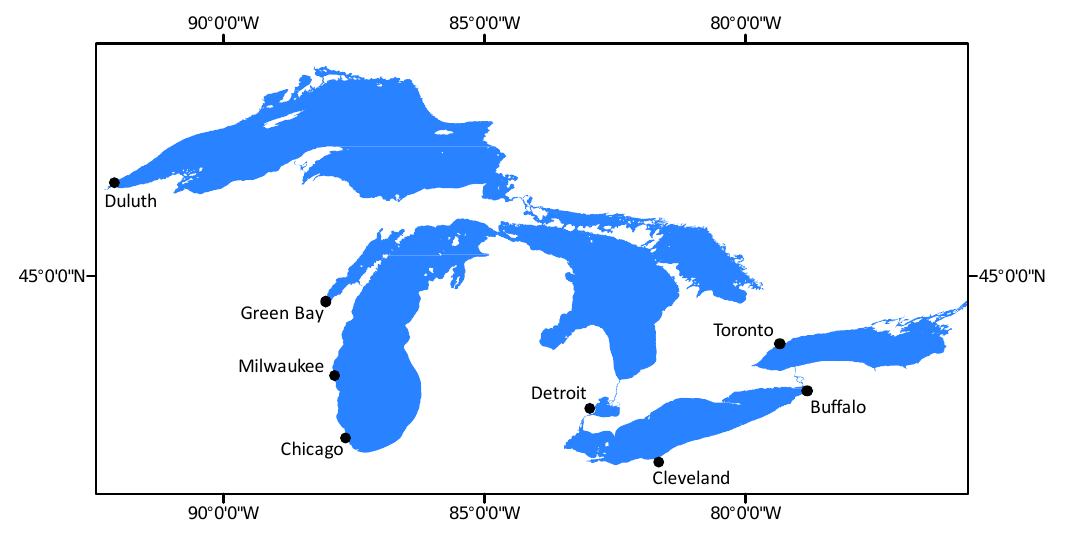
Figure 1. The Great Lakes domain, including Lakes Erie, Michigan, and Huron.